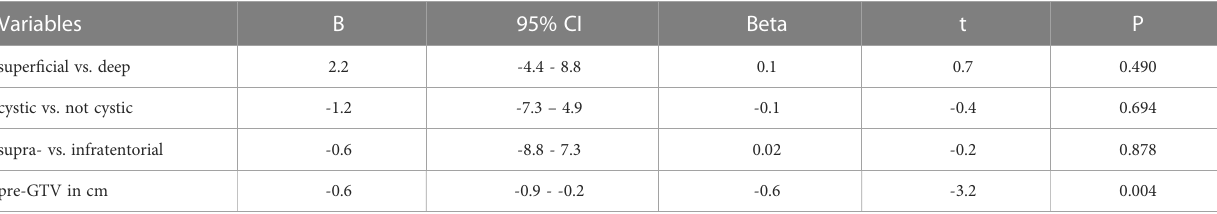
TABLE 5 Multiple linear regression analysis for prediction of GTV